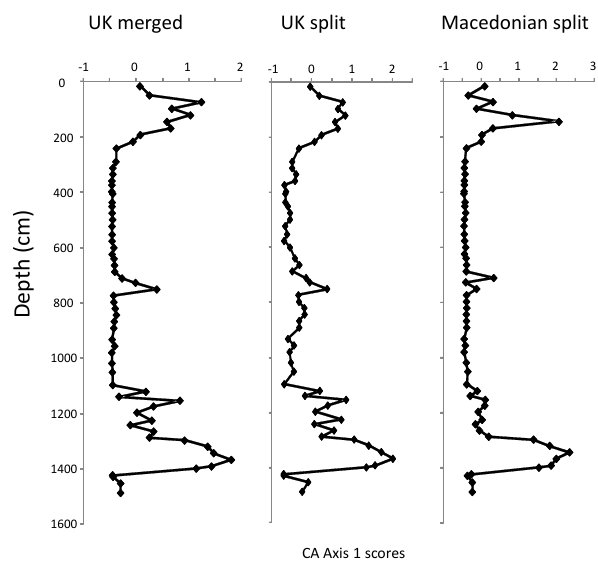
Fig. 4. Comparison of Axis 1 scores for correspondence analysis (CA) of the merged UK data-set ( Cyclotella fottii and C. ocellata as single species), the UK split data-set and the Macedonian split